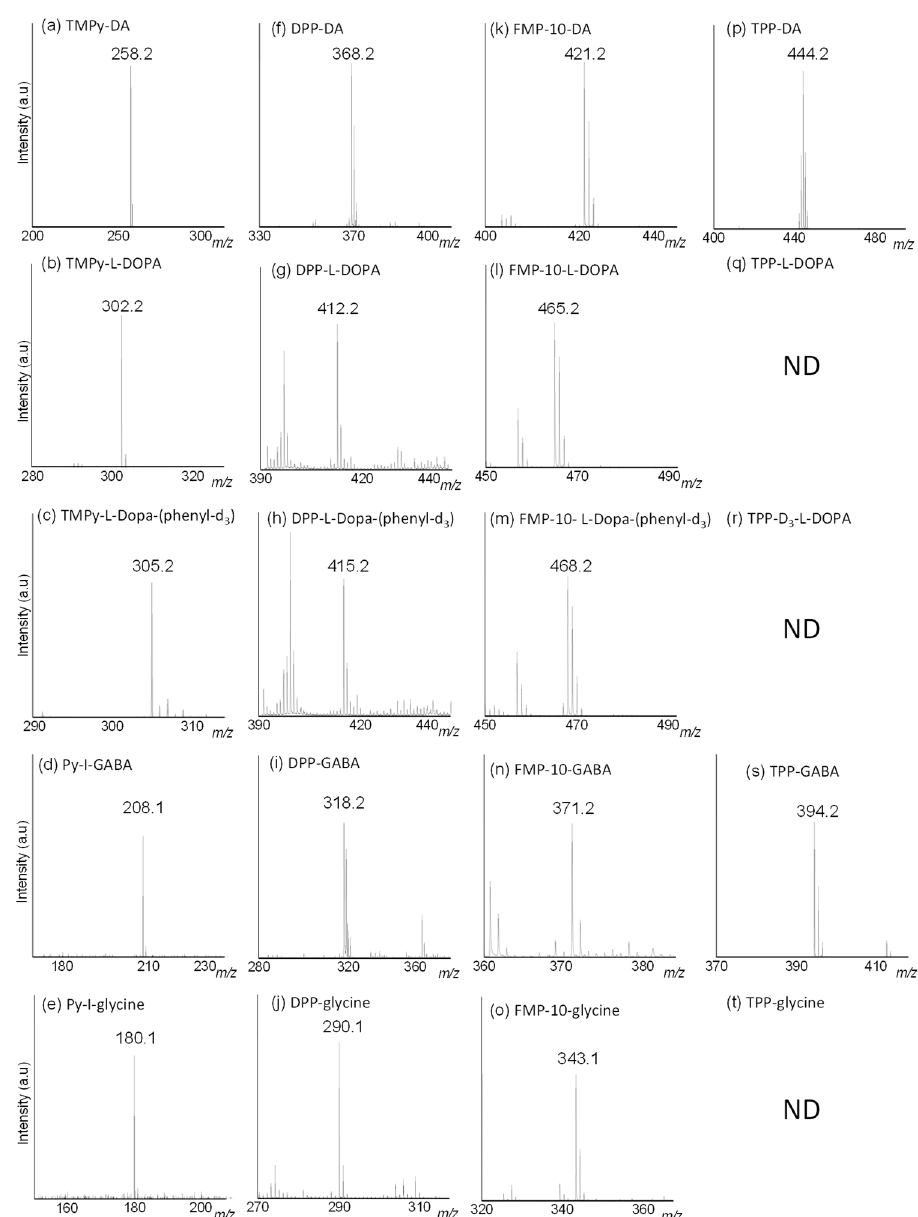
Figure 2. Mass spectra of TMPy-labeled dopamine (DA) ( a ), L-DOPA ( b ), L-Dopa-(phenyl-d 3 ) ( c ), GABA ( d ), and glycine ( e ). DPP-labeled DA ( f ), L-DOPA ( g ), L-Dopa-(phenyl-d 3 ) ( h ), GABA ( i ), and glycine ( j ). FMP-10-labeled DA ( k ), L-DOPA ( l ), L-Dopa-(phenyl-d 3 ) ( m ), GABA n), and glycine ( o ). TPP-labeled DA ( p ), L-DOPA ( q ), L-Dopa-(phenyl-d 3 ) ( r ), GABA ( s ), and glycine ( t ). ND = not detected.